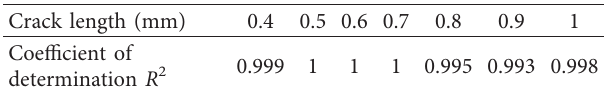
Figure 2: (a) Time domain. (b) Frequency domain spectra comparison of the intact and the cracked numerical models. Table 2: The coefficient of determination R 2 for the linear fitting of A 1 and A 2 .